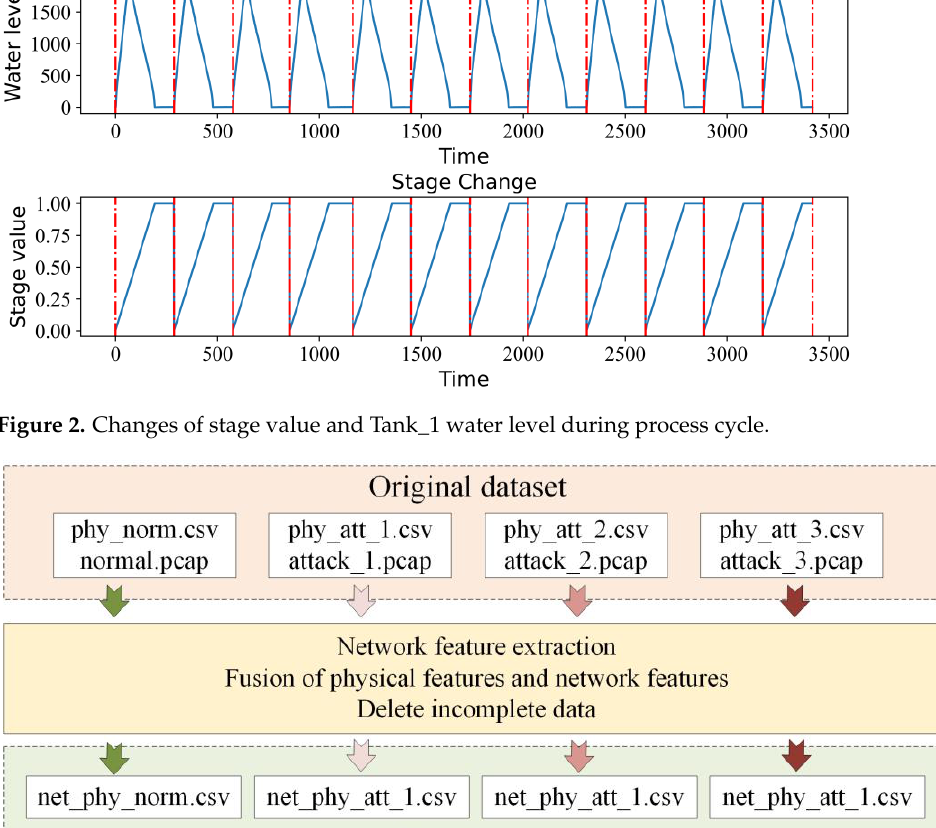
Figure 2. Changes of stage value and Tank_1 water level during process cycle.